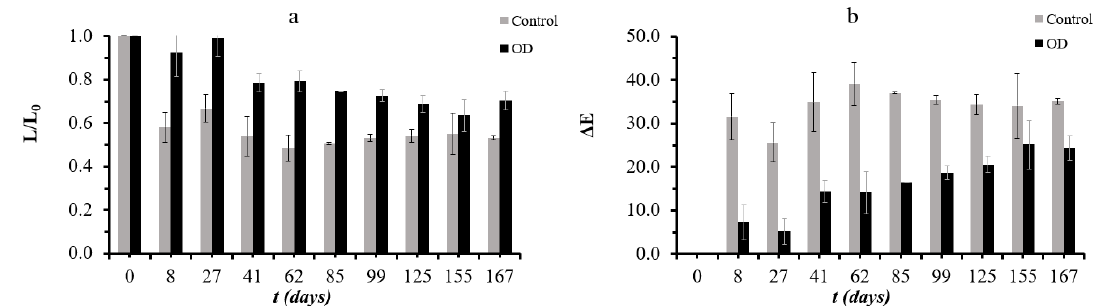
Figure 10. ( a ): Lightness maintenance (L/L 0 ) and ( b ): color difference ( ΔΕ ) during storage under frozen conditions. In ( a , b ), points represent average values, and error bars represent the standard deviation from the three measurements.